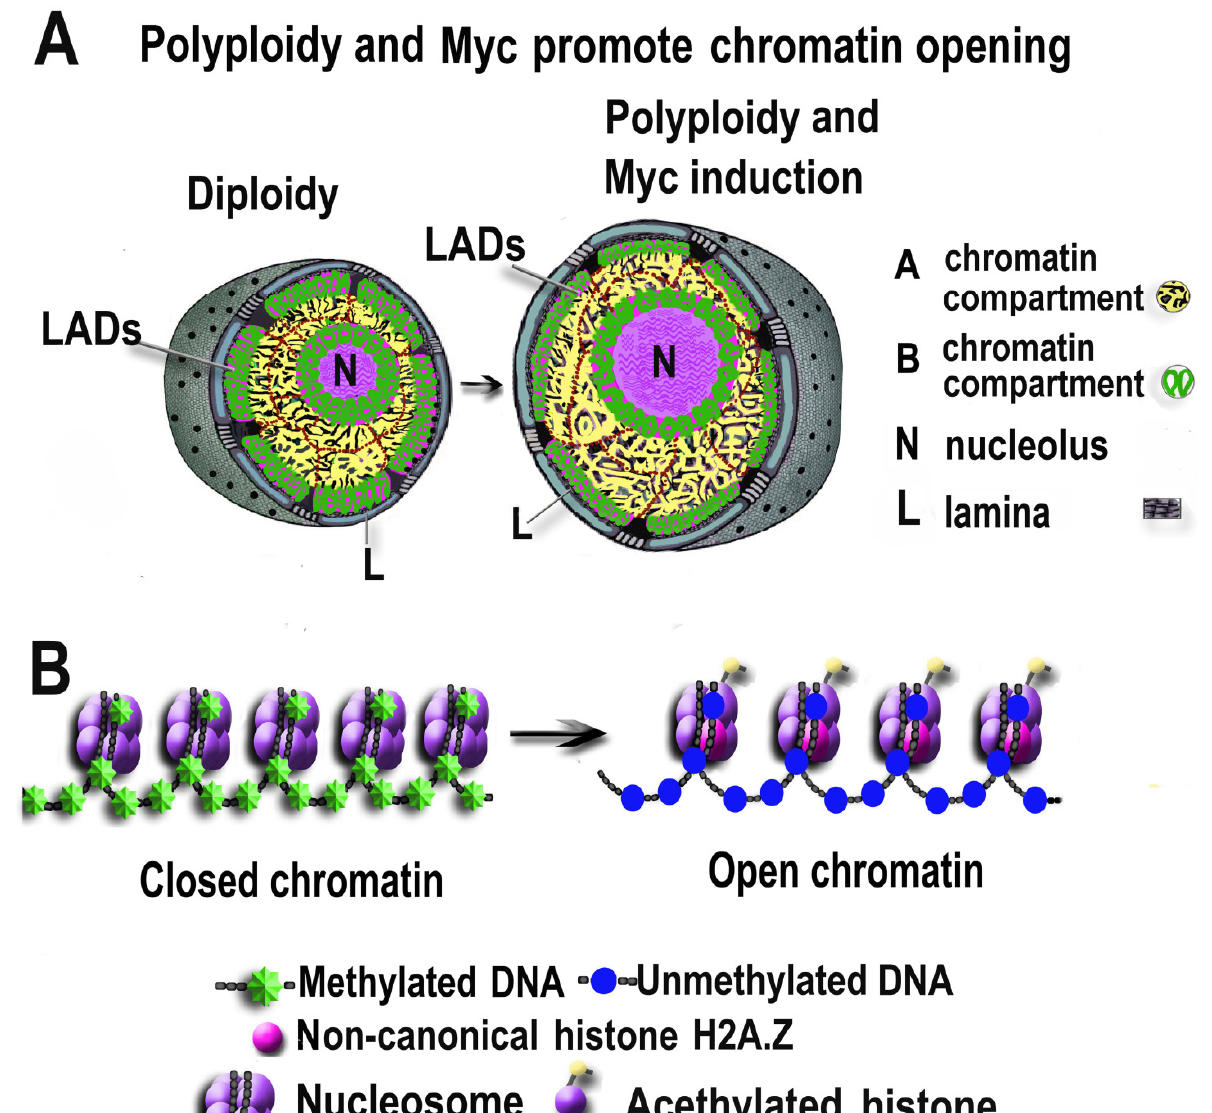
Figure 2. Polyploidy and overexpressed Myc promote chromatin opening via common effects at high ( A ) and low ( B ) levels of organization. A-chromatin opening due to lamina-associated domain detachment from the lamina and chromatin transition from B (closed) to A (open) state. B-chromatin opening due to DNA hypomethylation, histone acetylation, and substitution of canonical histones with non-canonical histone H2A.Z.